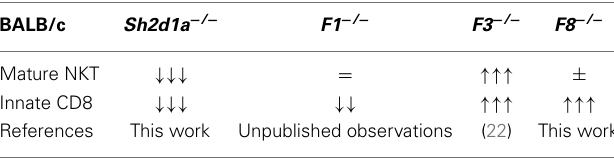
Table 3 | Effects of SAP and SLAMF receptor deficiencies on innateT cell development in the thymus of BALB/c